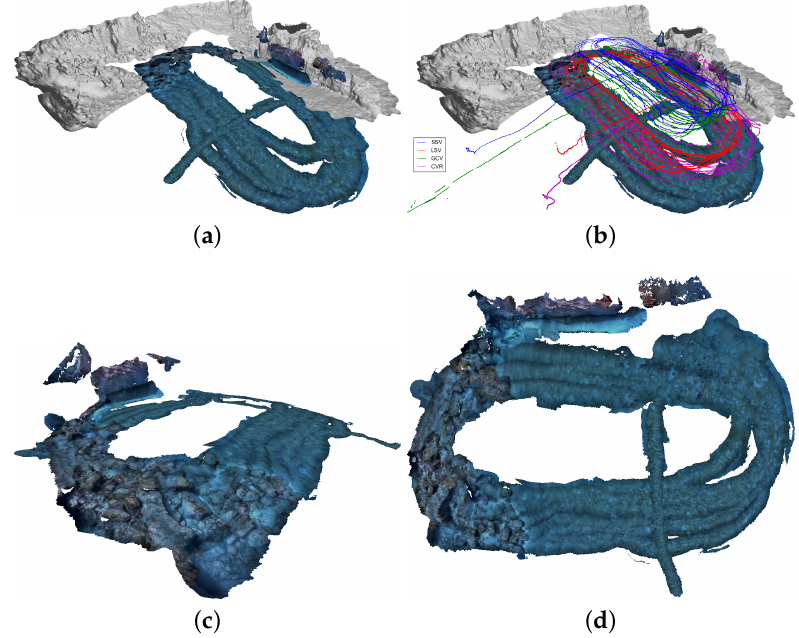
Figure 11. Morph Horta dataset at 11 September 2015: registered optical reconstruction. On ( a , b ) we show the reconstructions on the global map, with and without the trajectories; For more details, on ( c ) we show a slanted view highlighting the rocky area in this part; and in ( d ) we show a top